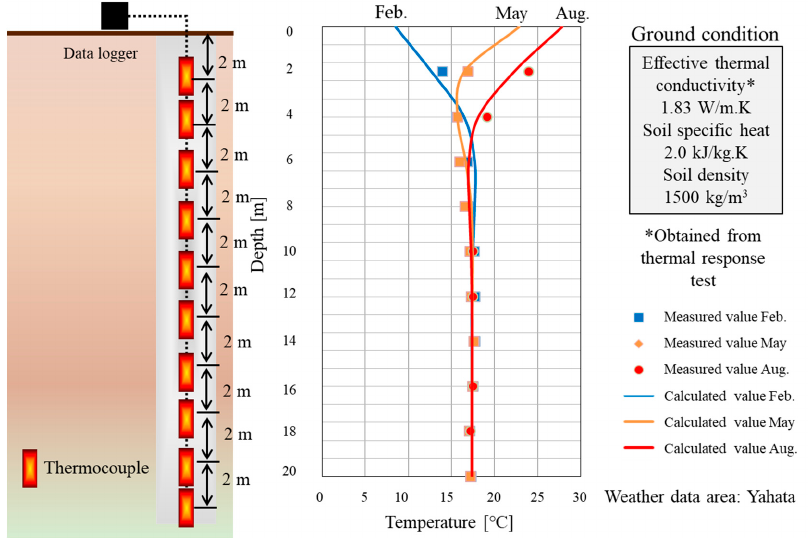
Figure 1. Schematic diagram of measuring underground temperature (left) and comparison between calculated and measured temperature (right).